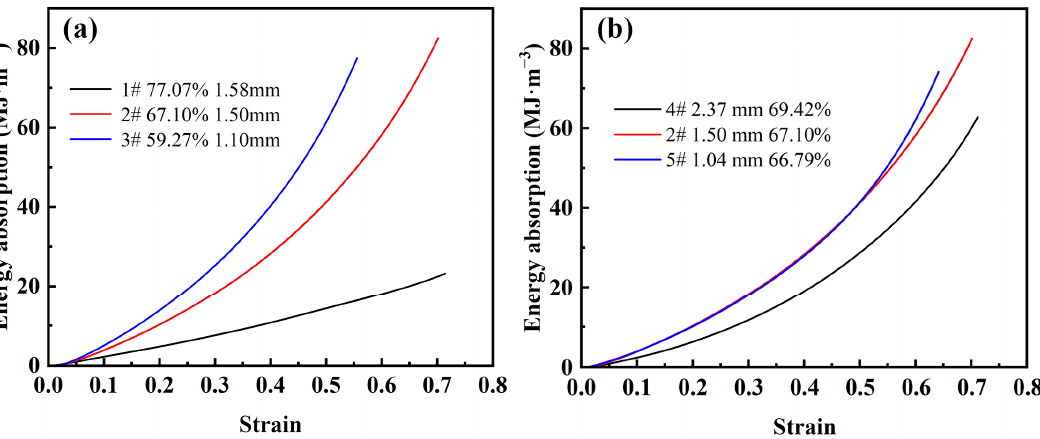
Figure 8. Energy absorption-strain curve of steel foam of ( a ) different porosity and ( b ) different pore size.